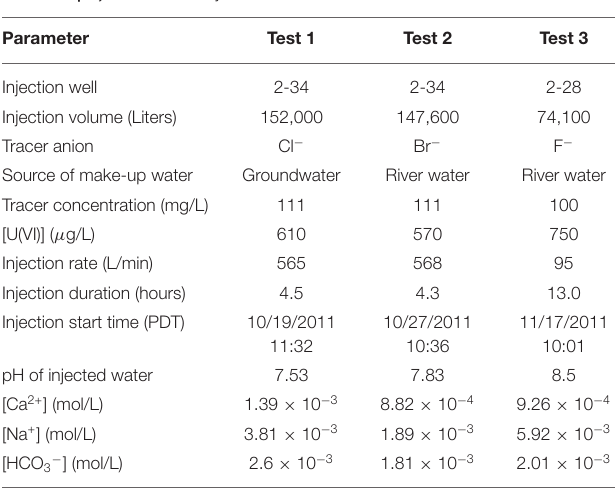
TABLE 1 | Injection